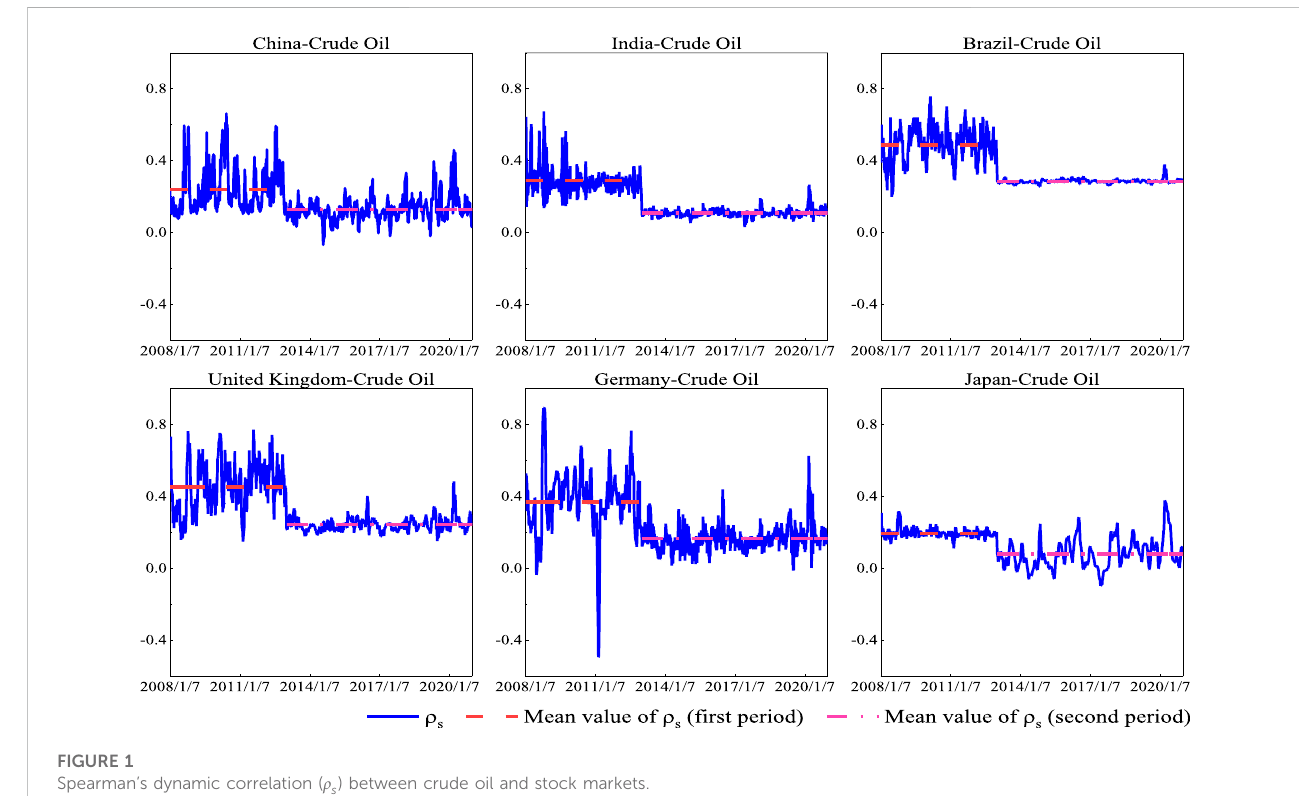
FIGURE 1 Spearman ’ s dynamic correlation ( ρ s ) between crude oil and stock markets.